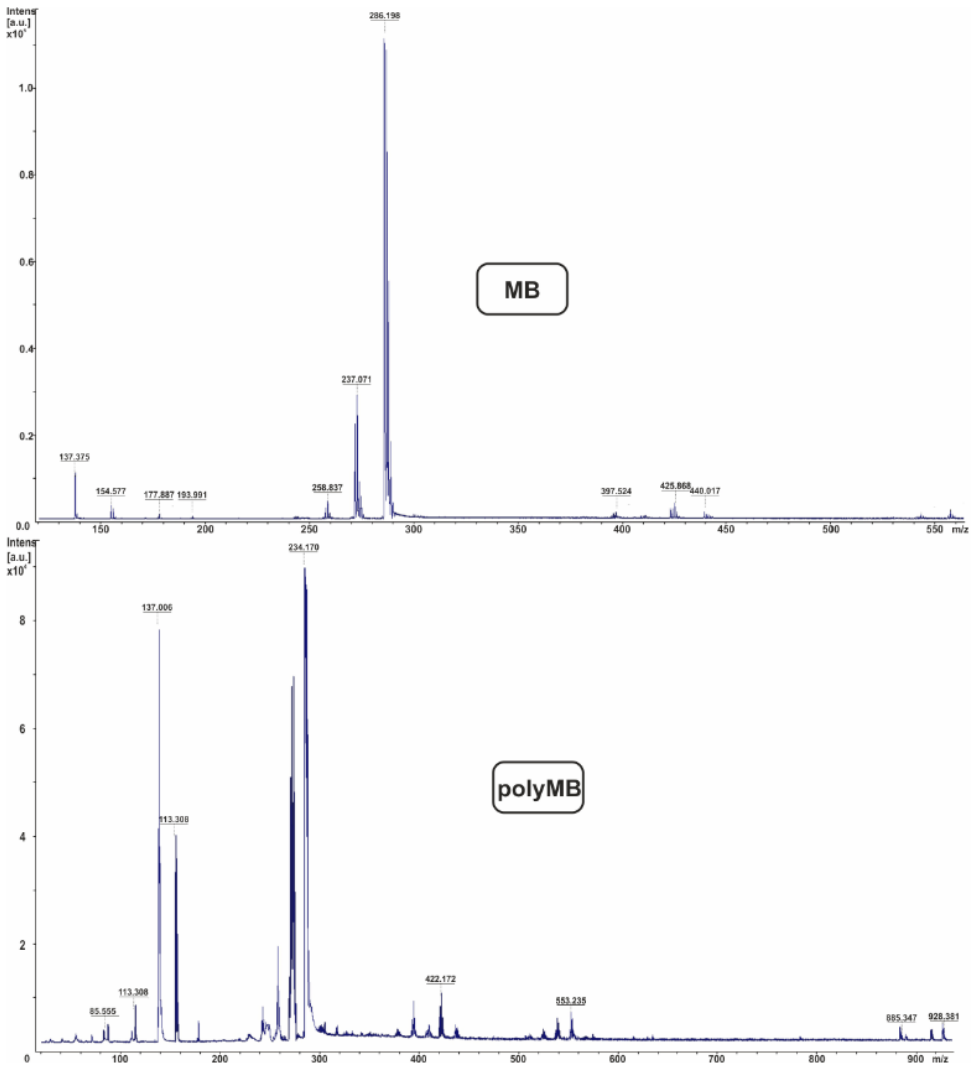
Figure 4. Spectra MALDI: MB—methylene blue; PolyMB—polymethylene blue.